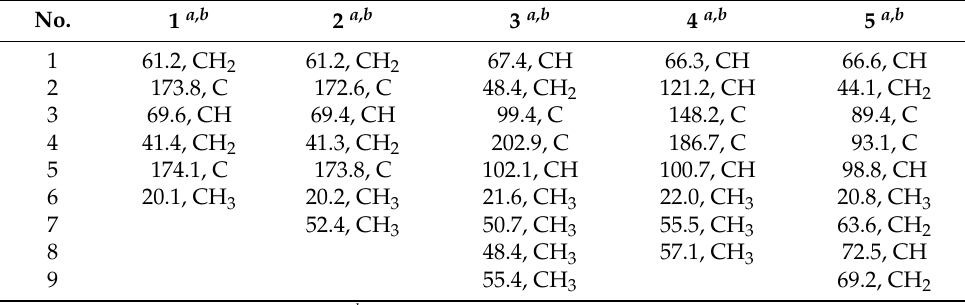
Table 1. 13 C NMR spectroscopic data for 1 – 5 ( δ in ppm, mult.).